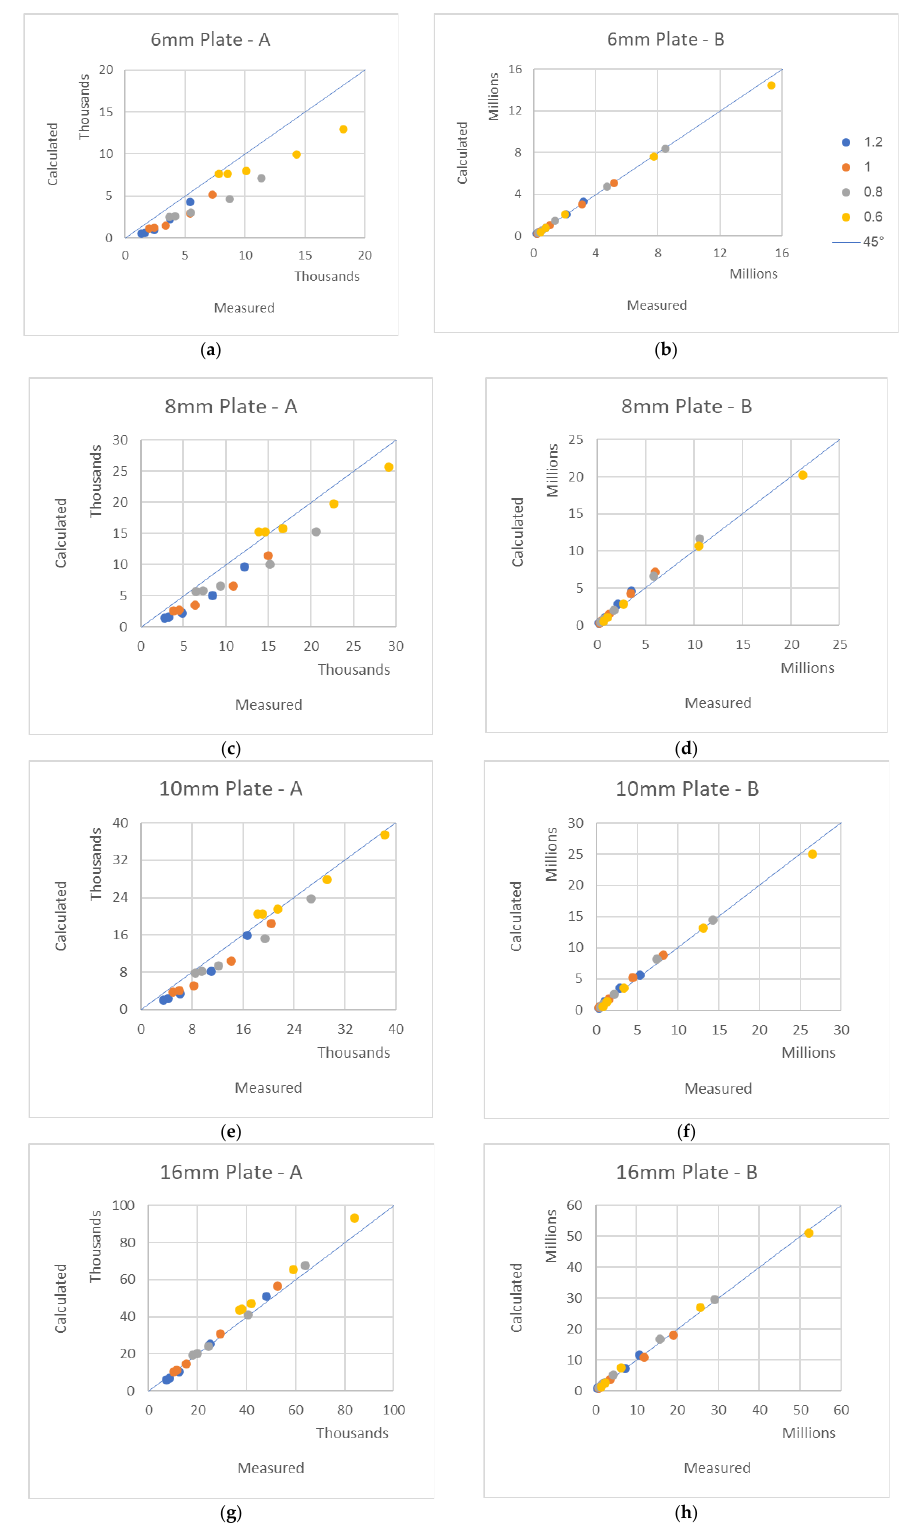
Figure 6. FEA-measured-calculated A , B expressions — a comparison of various plates: ( a ) 6 mm A, ( b ) 6 mm B with legend, ( c ) 8 mm A, ( d ) 8 mm B, ( e ) 10 mm A, ( f ) 10 mm B, ( g ) 16 mm A, ( h ) 16 mm B.